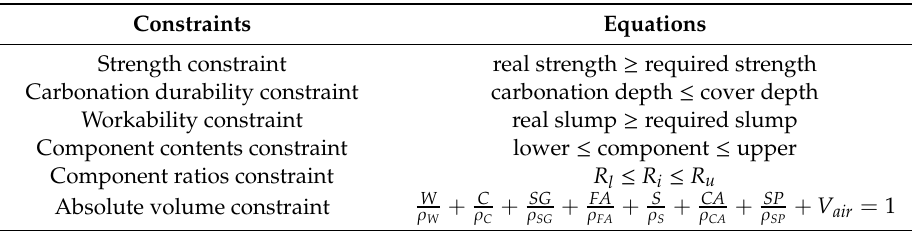
Table 4. Constraints of the mixture